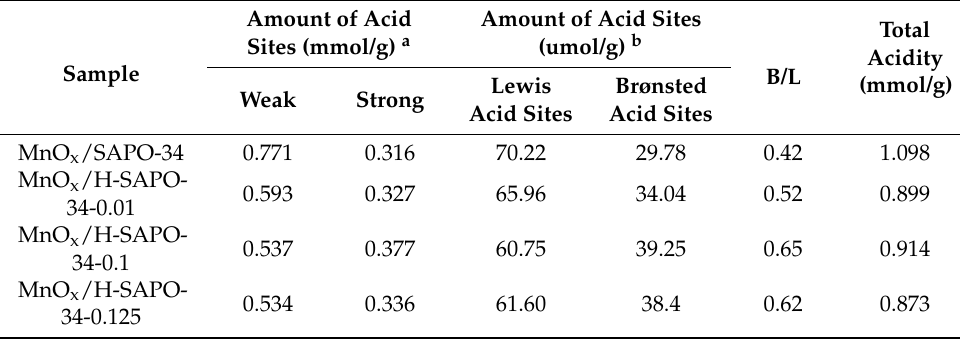
Figure 8. NH 3 -TPD ( a ) and Py-IR ( b ) profiles on MnO x /SAPO-34 and hierarchical MnO x /SAPO-34 catalysts. Table 2. Acidity data of MnO x /SAPO-34 and hierarchical MnO x / SAPO-34.